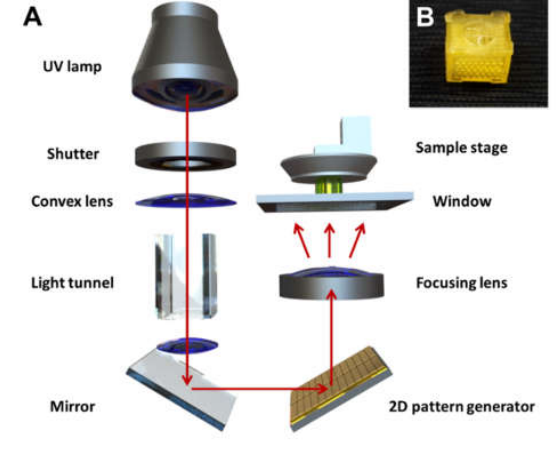
Figure 2. ( A ) A schematic diagram of the indirect 3D-printing system for sacrificial scaffold mold preparation and ( B ) a 3D-printed sacrificial mold.